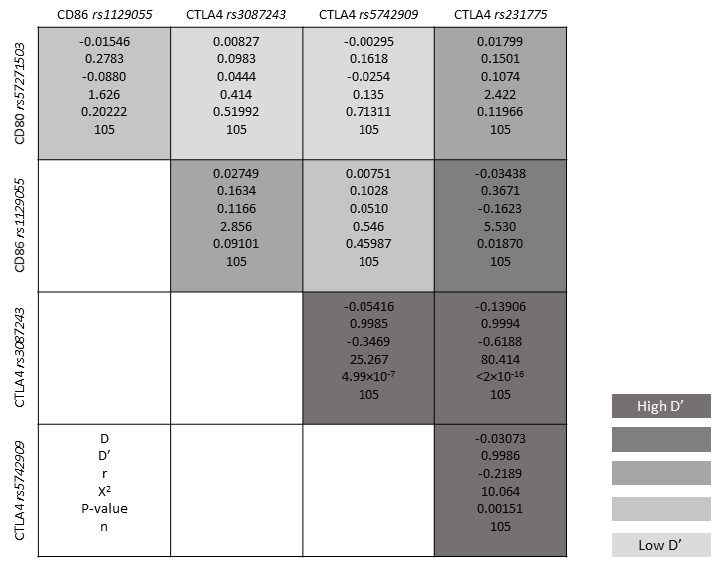
Figure 1. Linkage Figure 1. Linkage disequilibrium.